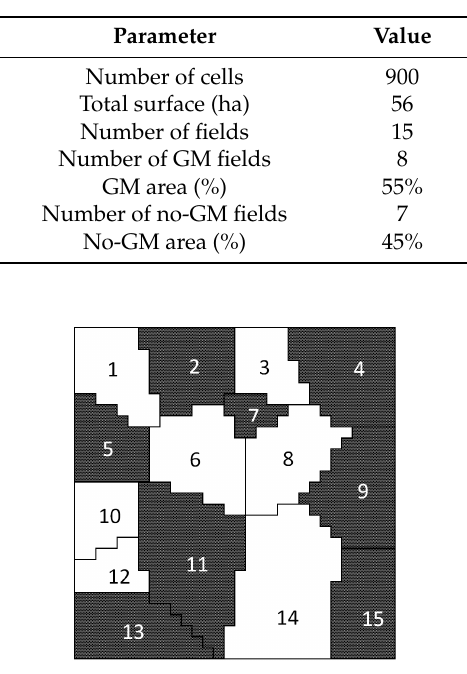
Figure 1. Spatial representation of fields from the Voronoi segmentation.